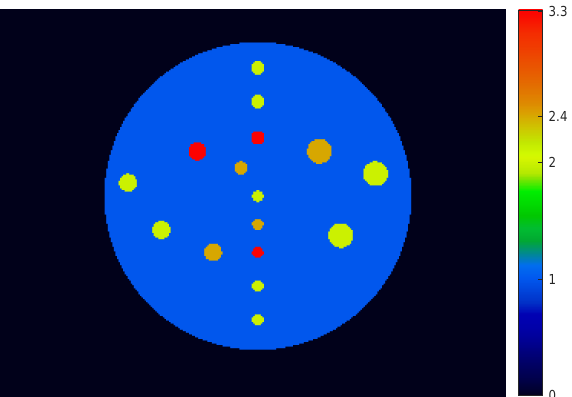
Figure 2. True image of the simulated phantom for background diameter D = 275